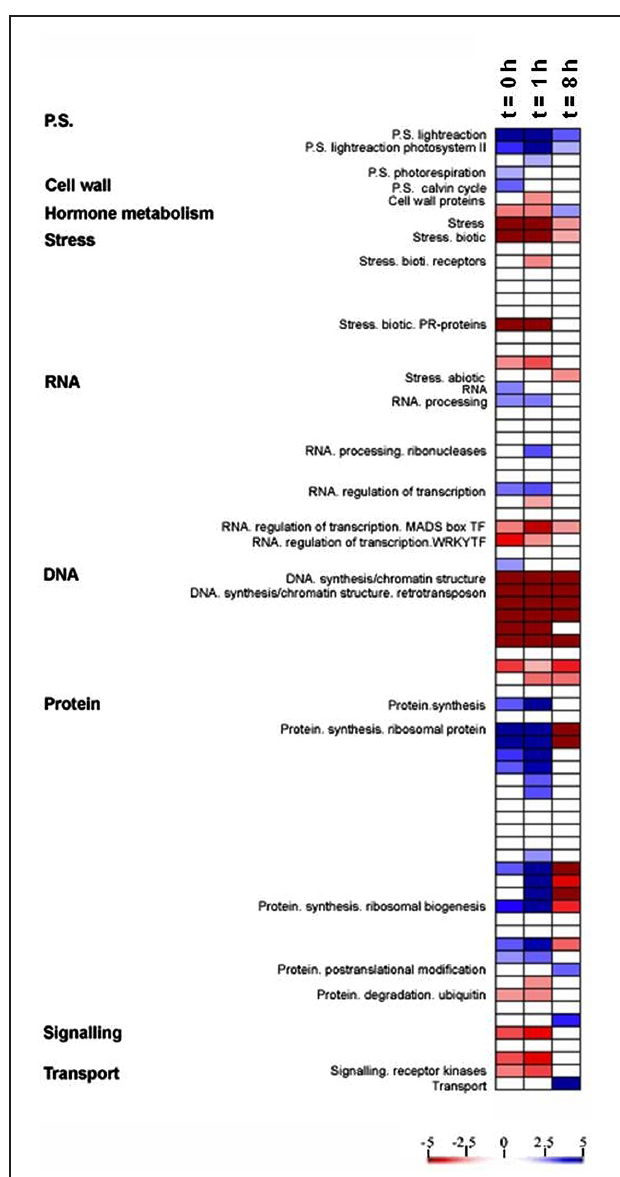
FIGURE 3 | Expression analysis in OE compared with WT. A condensed PageMap display of altered pathways is shown. Gene expression data are presented as log 2 fold changes in comparison with the same time point of WT. The analyzed points were t = 0, 1, and 8 h during light period. The data were subjected to a Wilcoxon test in PageMan, and the results are displayed in false-color